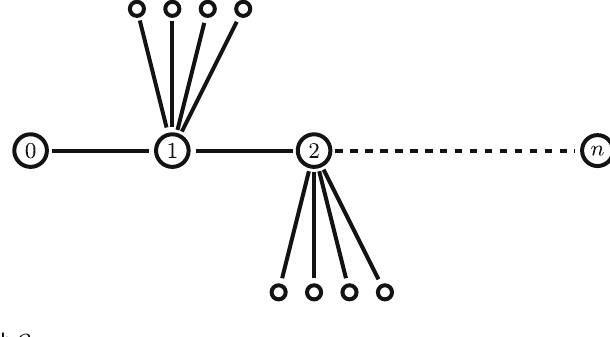
Figure 4: A caterpillar graph (cid:2)